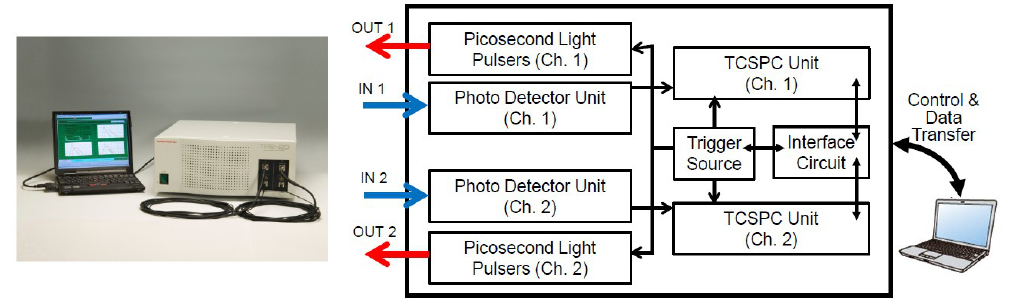
Figure 8. Photograph and block diagram of the TRS-20 system. The picosecond light pulser emit lights with wavelengths of 760, 800, and 830 nm; the photo detector unit consists of a variable optical attenuator, the photomultiplier tube (PMT), and a fast amplifier; the TCSPC unit consists of a CFD/TAC, an A/D converter, a histogram memory, etc.